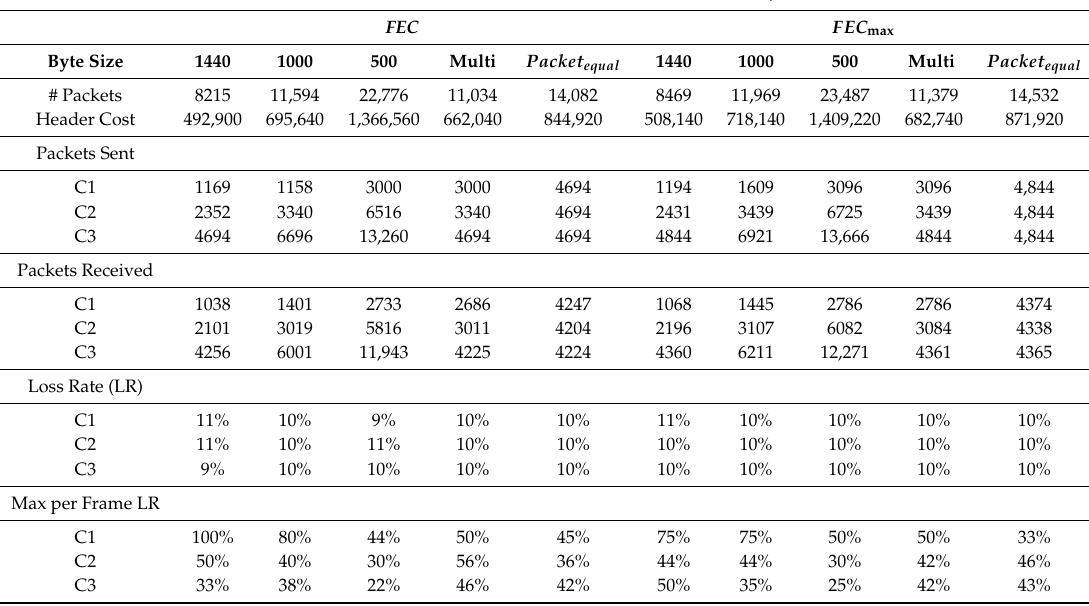
Table A4. FEC and FEC max models for all four Packet thres , as well as Packet equal . Values are illustrated for packets transmitted, additional packet header cost (60 bytes per packet for header information) and individual packets sent, packets received, loss rate per class and maximum loss rate per frame for SVC-SC, for an overall packet loss rate of 10% and a GOP of